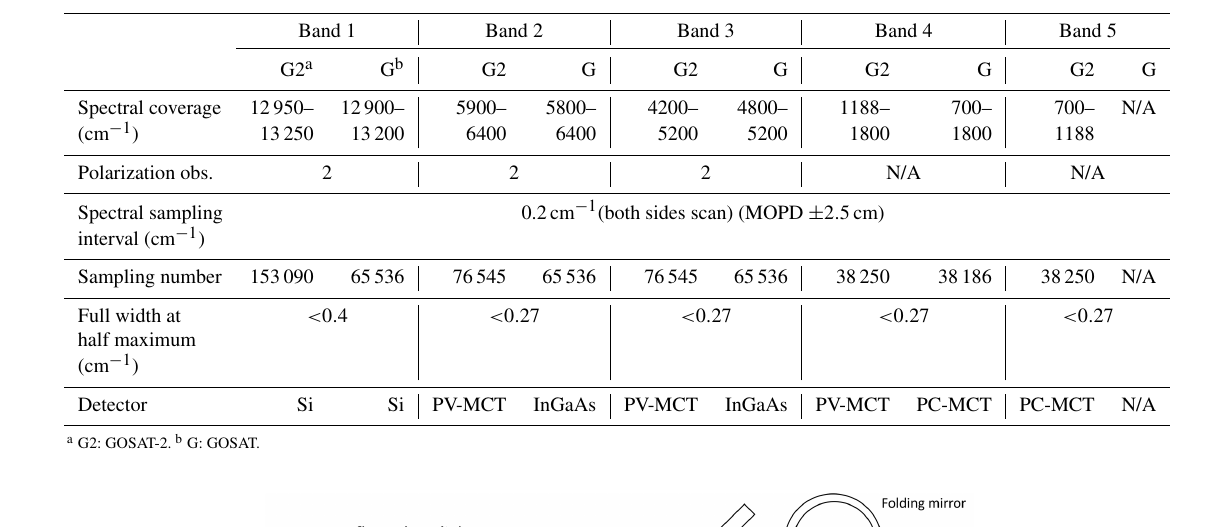
Table 2. Spectroscopic specifications of the TANSO-FTS-2. N/A means “not applied”.